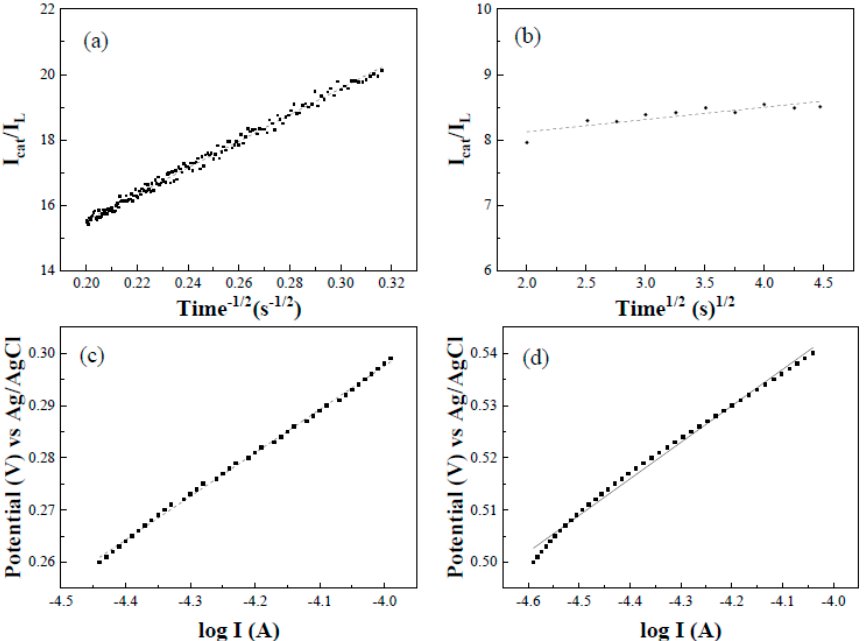
Figure 12. Dependence of I cat /I L on t 1/2 derived from the data of chronoamperometry in the presence of ( a ) 9 mM AA; and ( b ) 10 mM DA. Tafel plot of the Pt-Mo/C/GCE in the presence of ( c ) 10 mM AA; and ( d ) 15 mM DA.